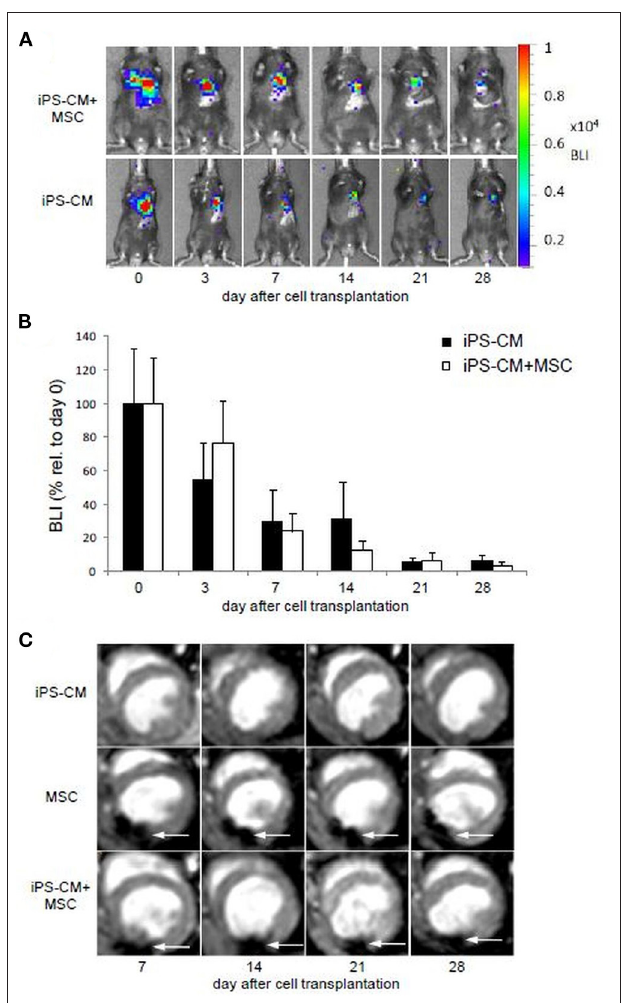
FIGURE 3 | Cell tracking and assessment of cardiac function after induction of MI and application of different cell therapy approaches. (A) BLI measurements showing representative animals from the group having received iPS-CM and iPS-CM + MSC over the course of 28 days. (B) Quantitative analysis of BLI in animals transplanted with iPS-CM ( n = 9) or iPS-CM + MSC ( n = 9). Data are given as mean ± SD of percentages of values relative to BLI on day 0 of cell transplantation. (C) MRI reveals the static location of the microsphere labeled MSC at the injection site over the course of 28 days in representative animals from the MSC and iPS-CM + MSC groups. Animals from the iPS-CM group showed no signal from injected cells. White arrows indicate signal voids caused by labeled MSC. BLI, Bioluminescence imaging; CM, cardiomyocytes; MSC, mesenchymal stromal cells; iPS, induced pluripotent stem cell.